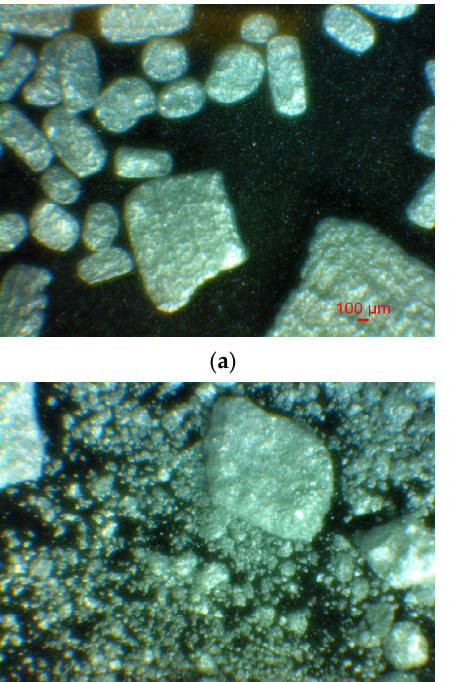
( h ) Figure A2. Optical microscope images of scrap and copper composites ball milled at different conditions: ( a ) 50–70 μ m copper powder, 2 h, 5 mm steel balls; ( b ) 50–70 μ m copper powder, 2 h, 10 mm steel balls; ( c ) 50–70 μ m copper powder, 1 h, 10 mm steel balls; ( d ) 50–70 μ m copper powder, 1